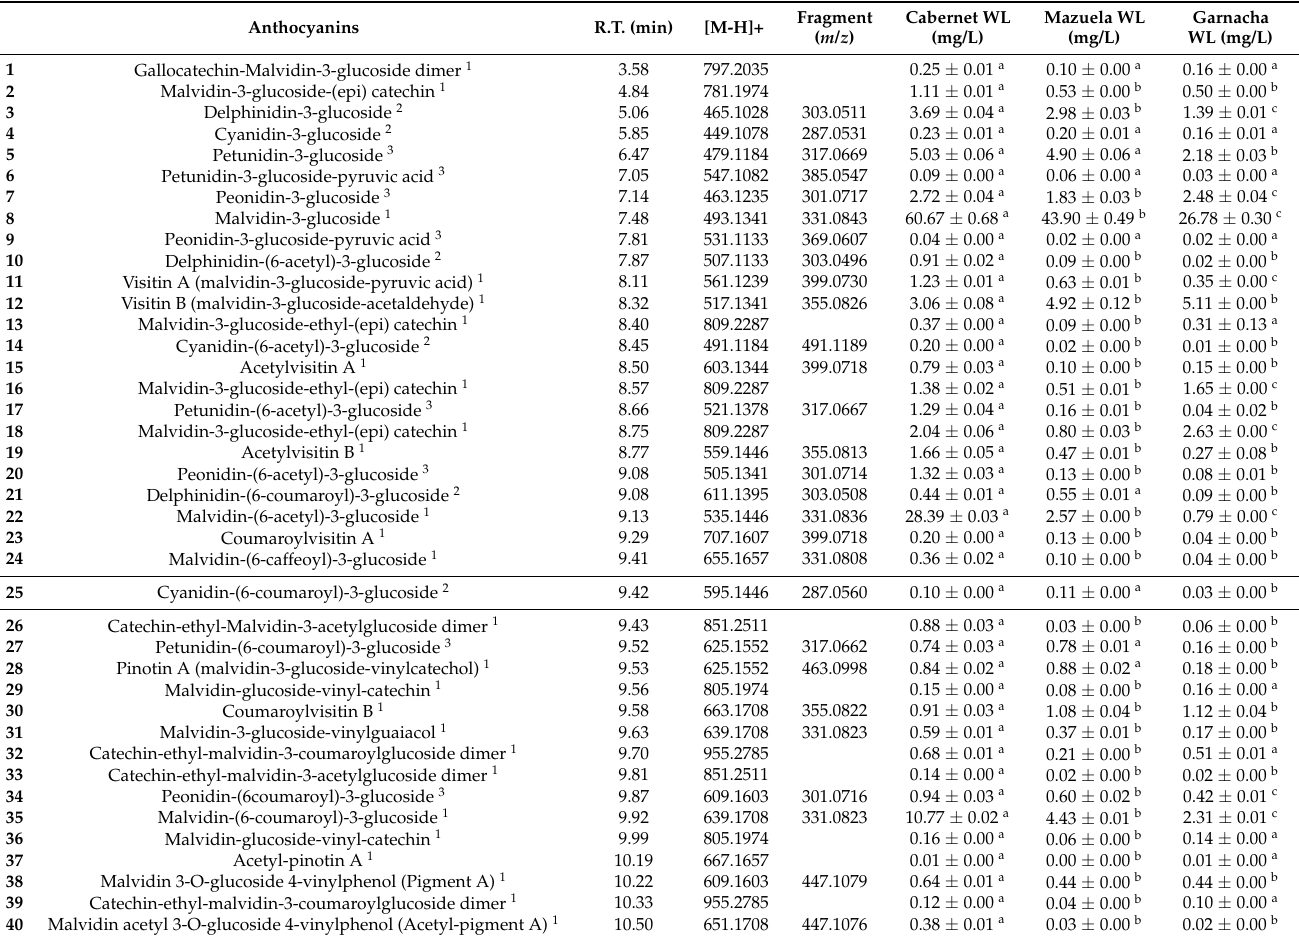
Table 4. Characterization of anthocyanin in Cabernet, Mazuela, and Garnacha wine lees (WL) by UHPLC- (ESI